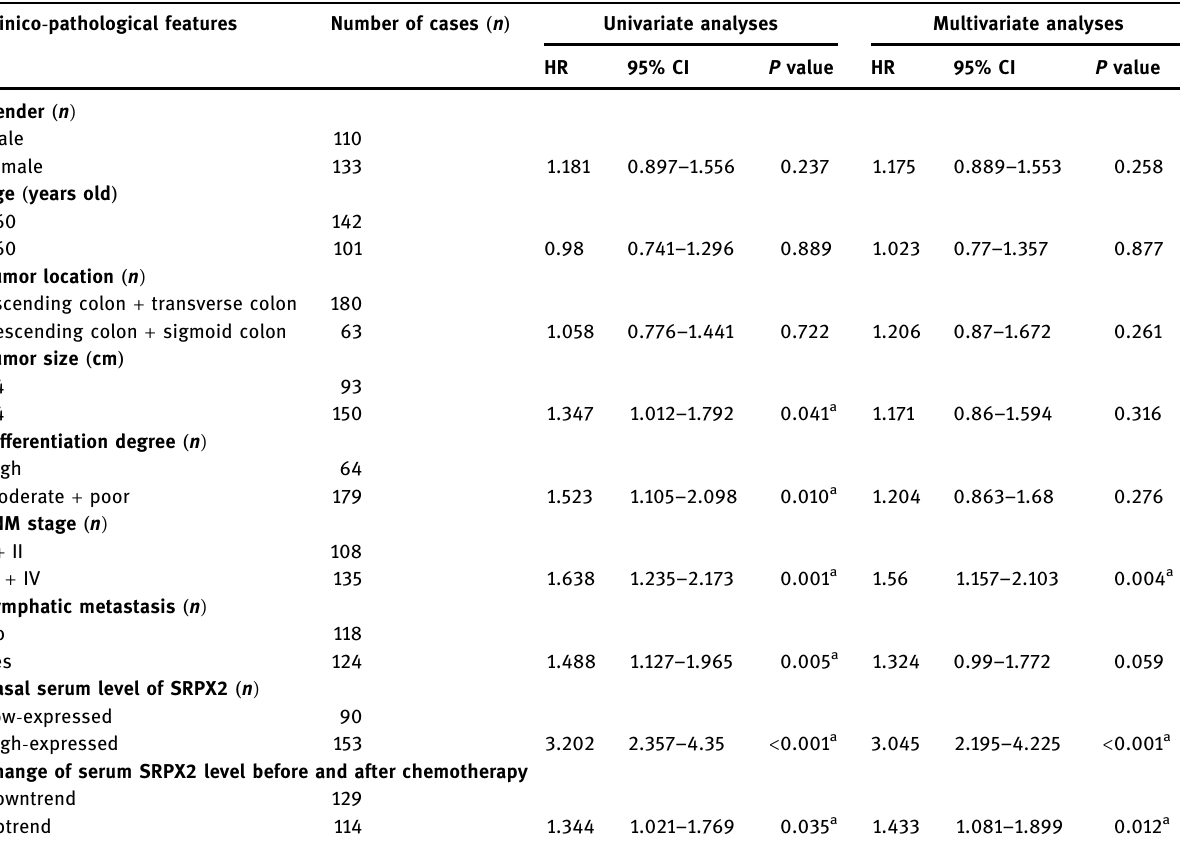
Table 1: Signi fi cance of clinico - pathological features in predicting 3 - year survival of PC patients Clinico - pathological